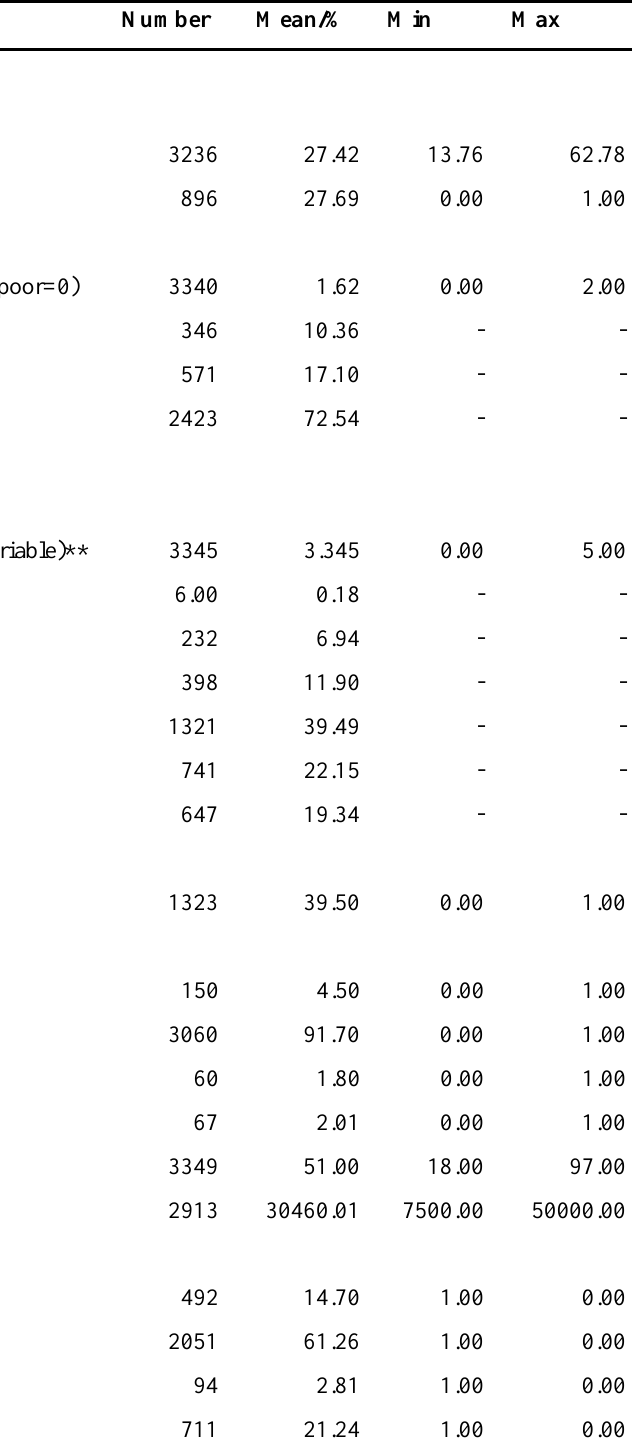
Table 1. Descriptive statistics for dependent, demographic, income and employment